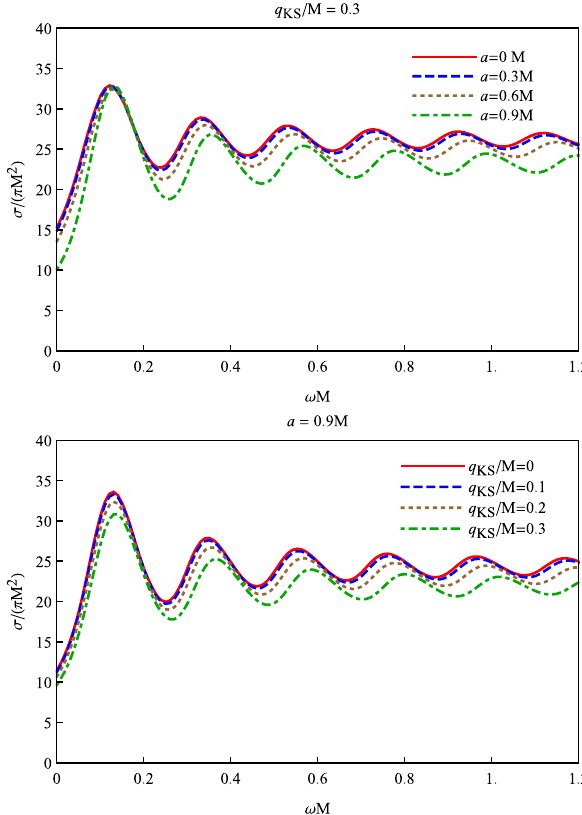
Fig. 2 Totalabsorption crosssectionforfixedcharge (top)andangular momentum per unity mass (bottom) of the KS black hole. Both panels are plotted for polar incidence ( γ = 0)